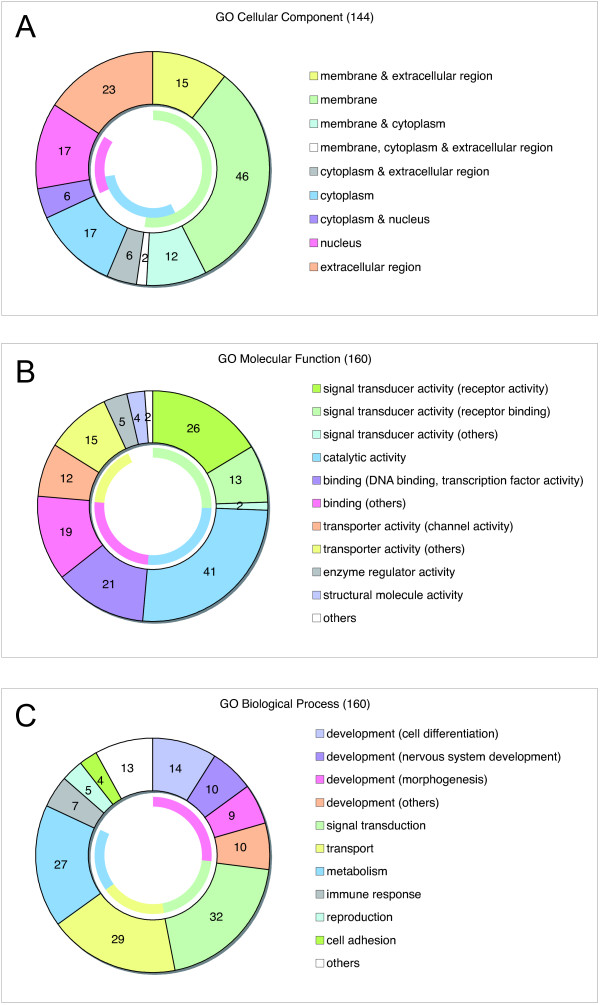
Gene ontology (GO) analyses of the genes that were differentially expressed between rSey2/rSey2 and WT rat hindbrains at E11.5. Annotated genes were selected by t-test using the cross-gene error model (p < 0.05). The genes are categorized by the following GO terms: cellular component (144, A), molecular function (160, B) and biological process (160, C), and are displayed in doughnut charts. Internal color arcs indicate the total rates for each category: (A) membrane (green, 52.1%), cytoplasm (blue, 29.9%) and nucleus (red, 16.0%); (B) signal transducer (green, 25.6%), catalytic (blue, 25.6%), binding (red, 25.0%) and transporter (yellow, 16.9%) activities; and (C) development (red, 26.9%), signal transduction (green, 20.0%), transport (yellow, 18.1%), and metabolism (blue, 16.9%). The details of the annotated genes and GO terms are shown in Additional file 3.